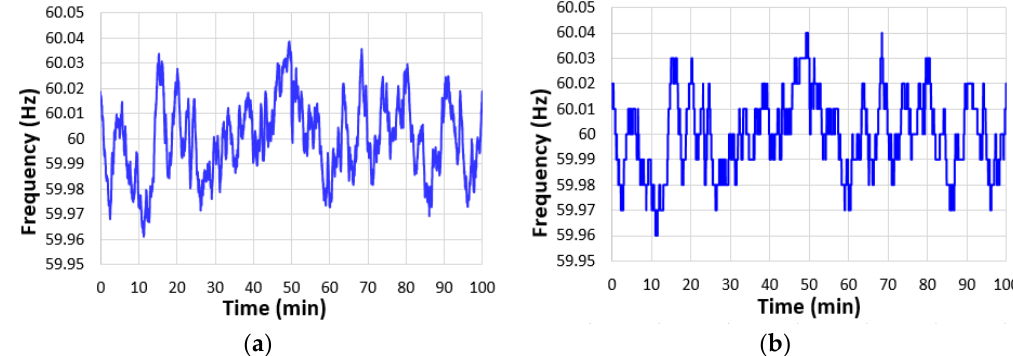
Figure 2. Frequency data ( a ) collected from the input grid at the NRC campus at 08:30 for 100 min on 15 May 2018, and ( b ) rounded as for the inputs to the grid simulator for primary frequency control (PFC) simulation testing.